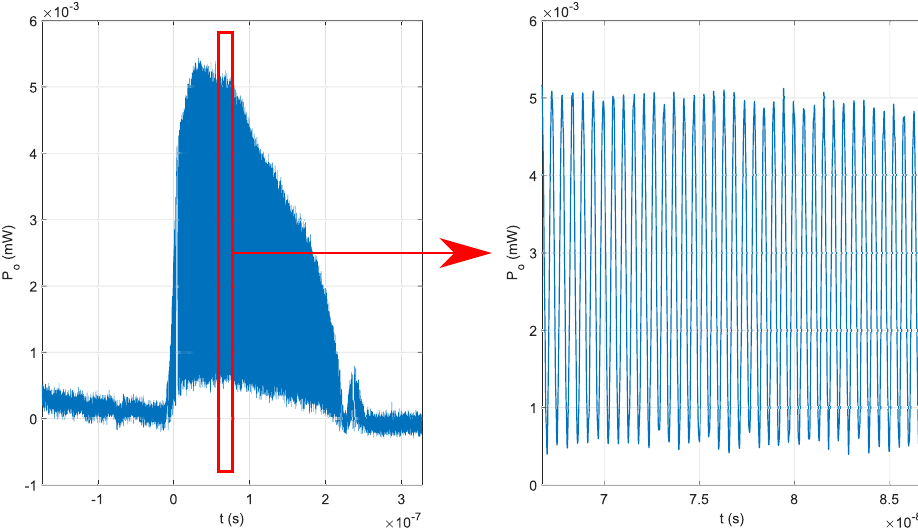
Figure 6. The maximal measured optical power without EDFA and with the Michelson interferometer with ∆ L = 0.03 m was 5.2 mW. The observed maximal optical power and the optical signal waveform were stable, as shown in Figure 6.